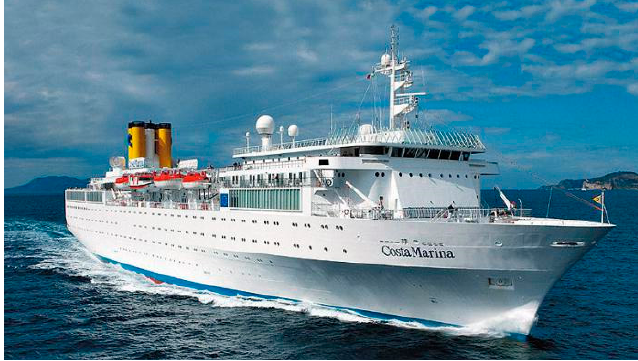
Figure 5. Costa cruise ship (https://baike.baidu.com (accessed on 1 February 2021)). Figures 6–8 show a three-layer ship network node diagram: (F1, F2, . . . F35) represent the nodes on the first floor of the cruise ship, (S1, S2, . . . S28) indicate the nodes on the second floor, T represents the nodes on the third floor, and (E1, E2, E3, E4, E5, E6, E7, E8, E9, E10) represent the stairs. The first floor has 35 nodes and 4 stair nodes, the second floor has 30 nodes and 4 stair nodes, and the third floor has 11 nodes and 2 stair nodes. Each pathway from one node to another node is thus